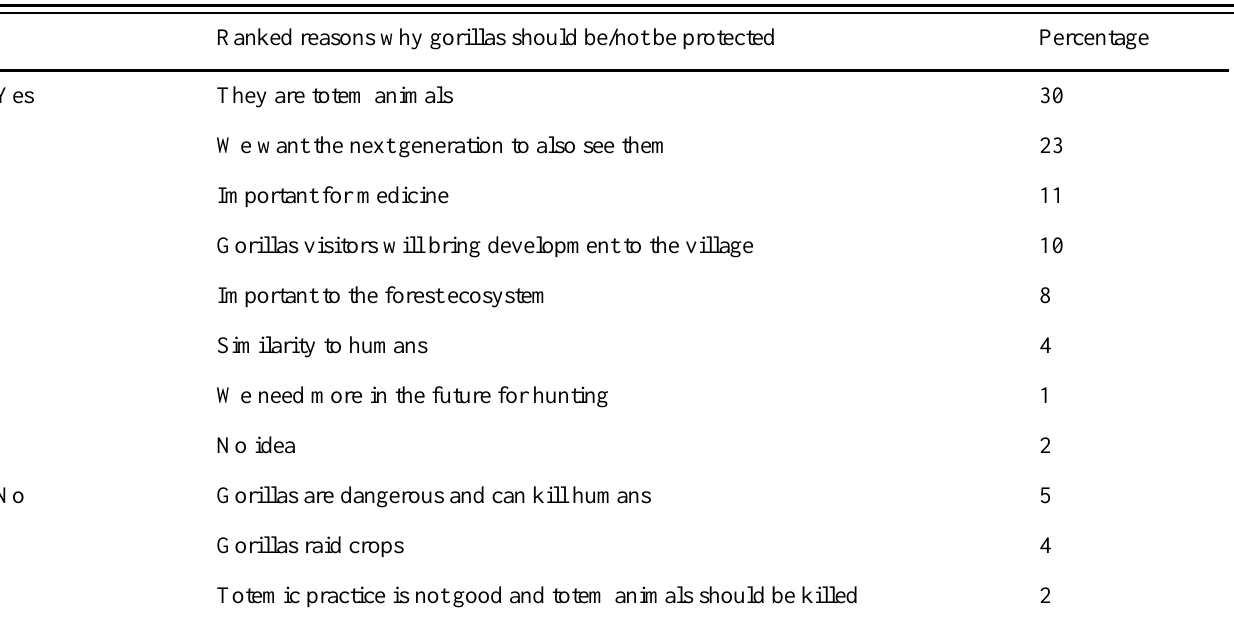
Table 2. Response to the question “Should gorillas be protected” by villagers in the Lebialem Division of South West Region, Cameroon (percentage of all respondents, N =